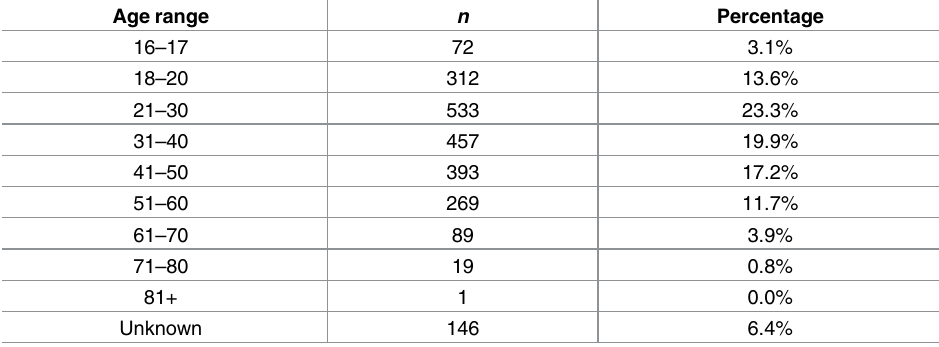
Table 2. Descriptive statistics for participant age ( n =